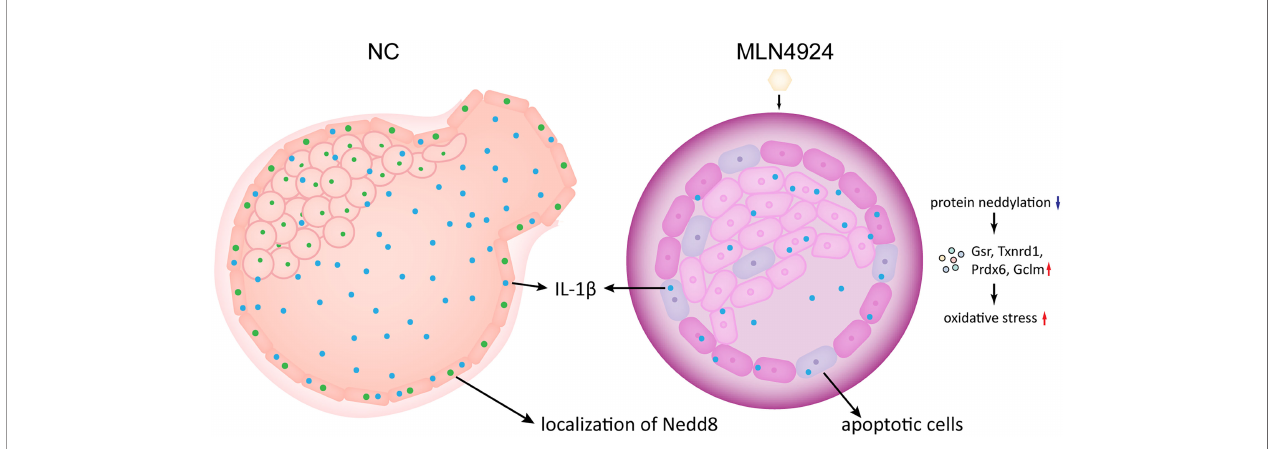
FIGURE 5 | A schematic representation of the neddylation block causing blastocyst hatching failure. With MLN4924 in mouse blastocyst inhibits protein neddylation, leading to putative aberrant protein degradation and turnover, and raise the integral oxidative stress level. At the same time, the overall oxidative stress level increased and the secreted IL-1 b reduced, accompanied by elevated DNA damaging, mitochondrial dysfunction and apoptosis. The restricted embryo growth also caused abnormal hydrostatic pressure in the blastocyst. Altogether the fi nal blastocyst hatching failure takes